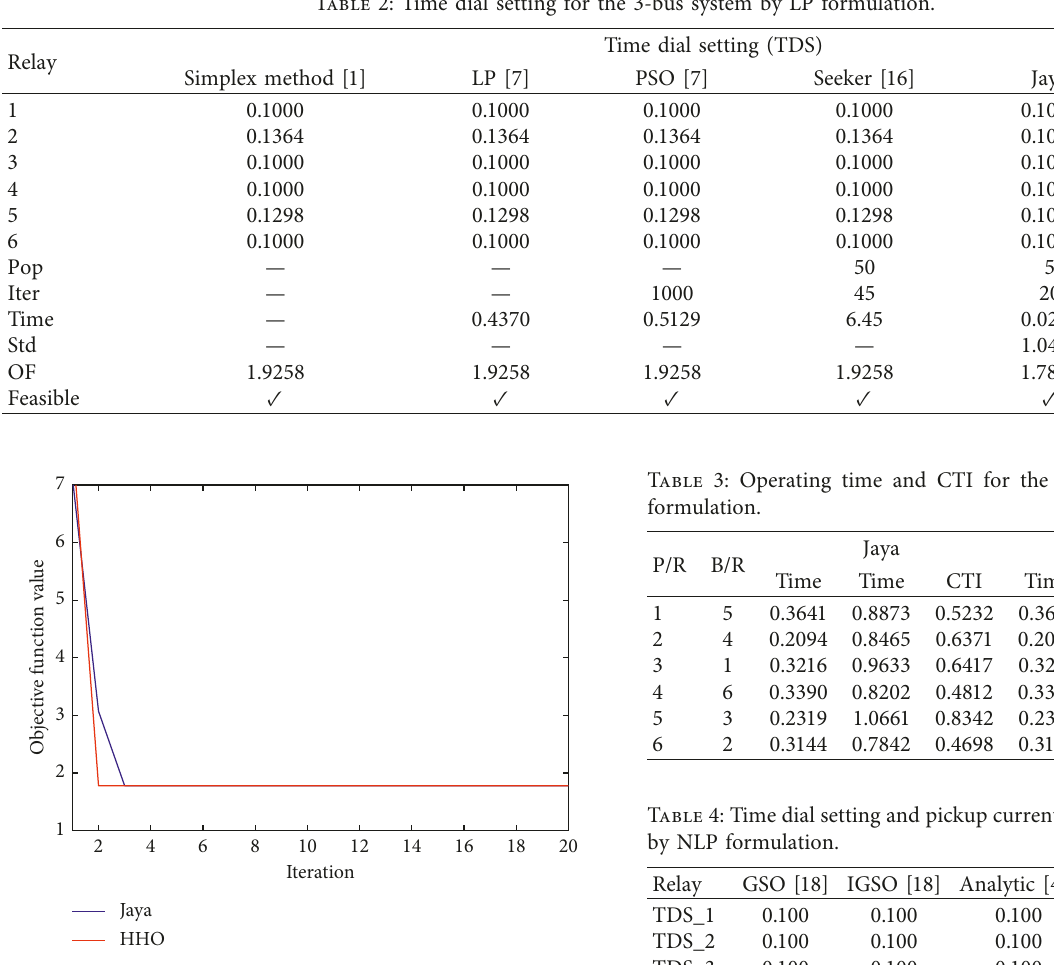
Figure 2: Convergence characteristics for the 3-bus system by LP formulation.